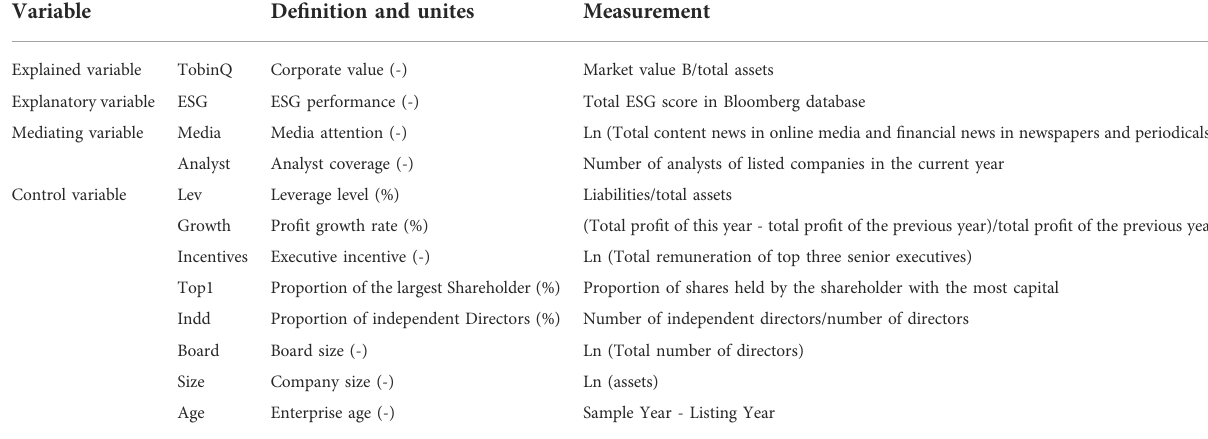
TABLE 1 Variable de fi nition.